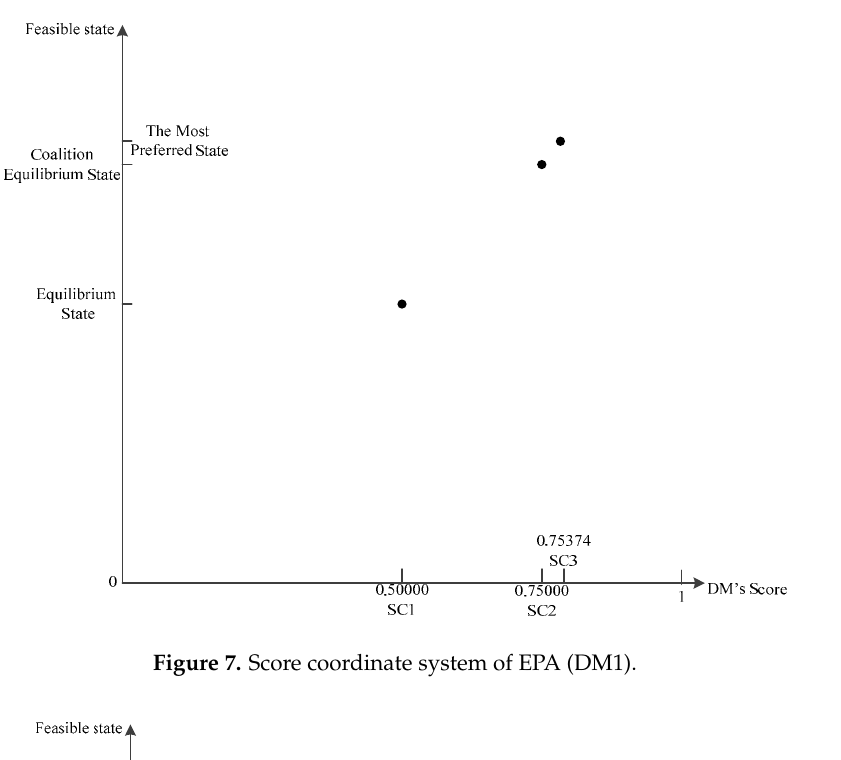
Figure 7. Score coordinate system of EPA (DM1).